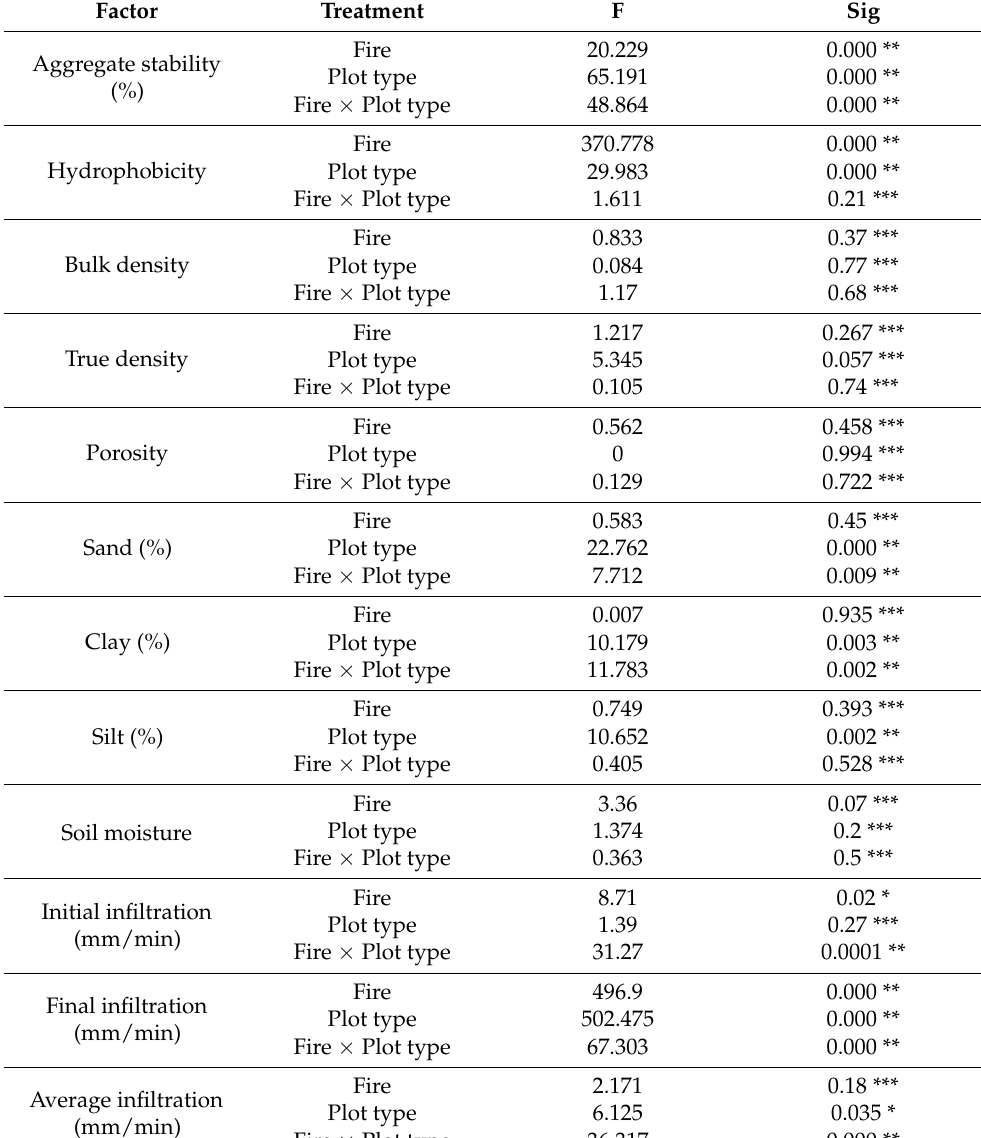
Table 2. Two-way analysis of variance of soil physical properties in fire and non-fire treatments.